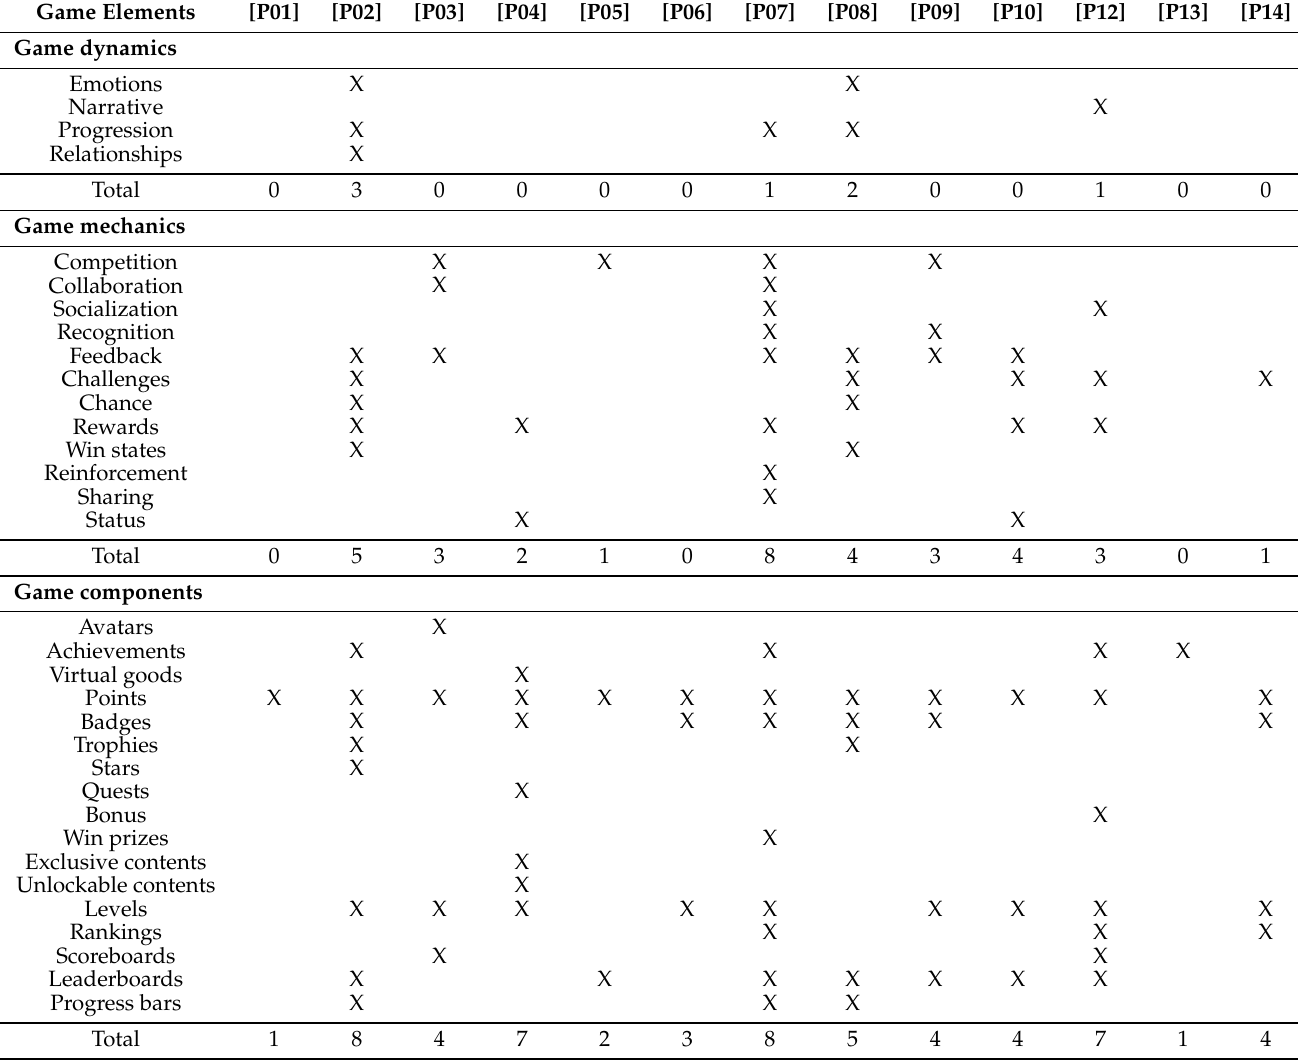
Table 13. Game elements included in the primary